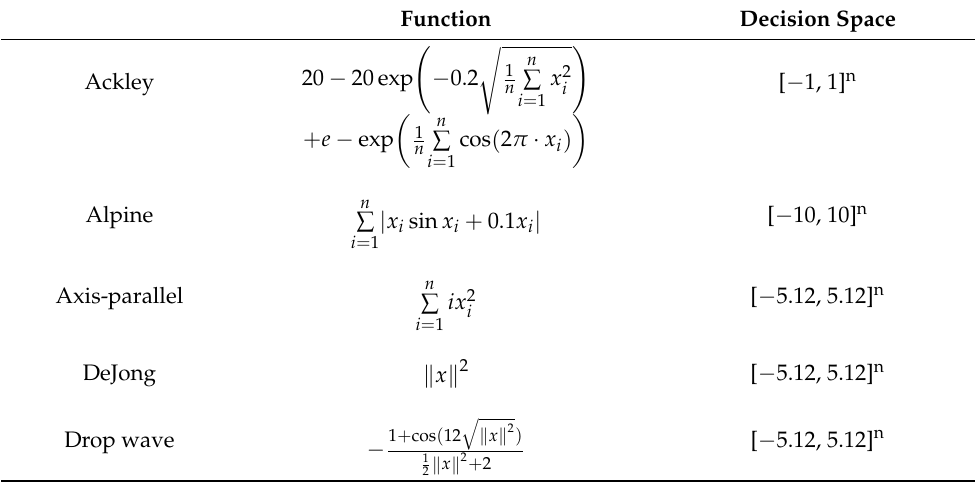
Table 6. Benchmark functions used for testing noise handling performance.